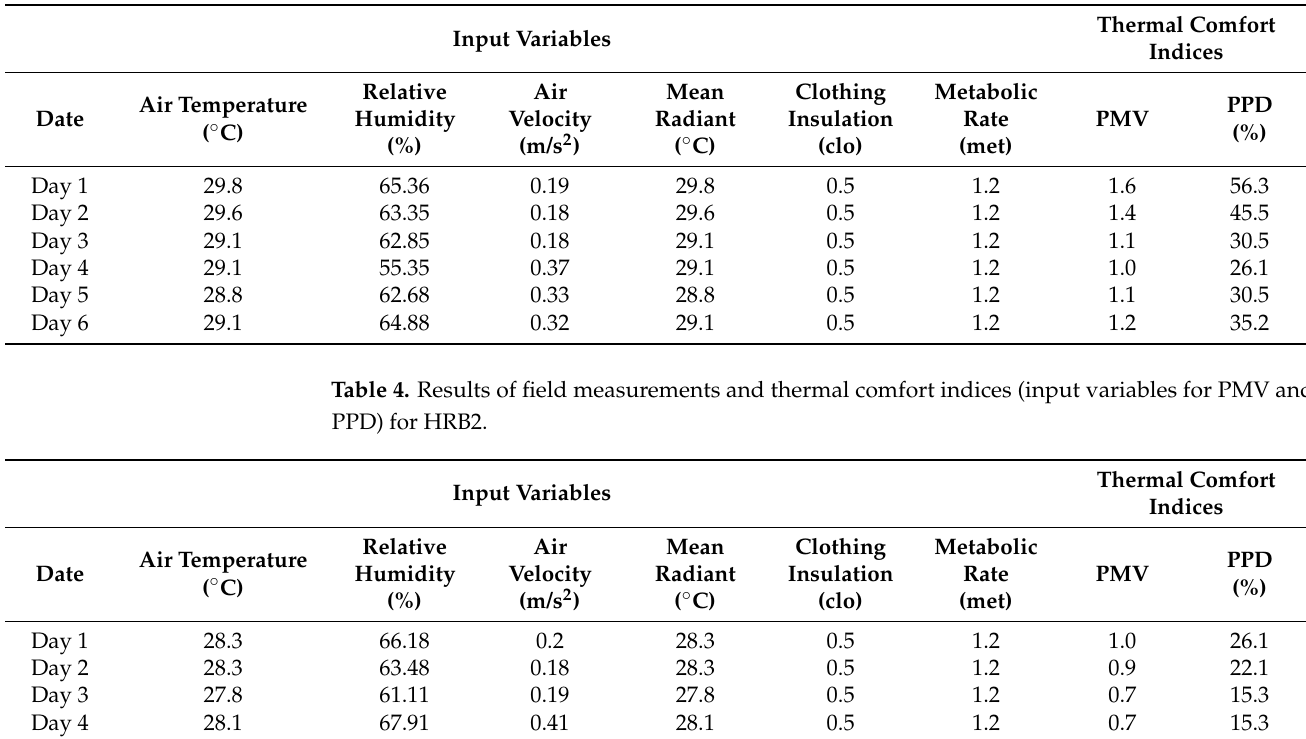
Table 3. Results of field measurements and thermal comfort indices (input variables for PMV and PPD) for HRB1.